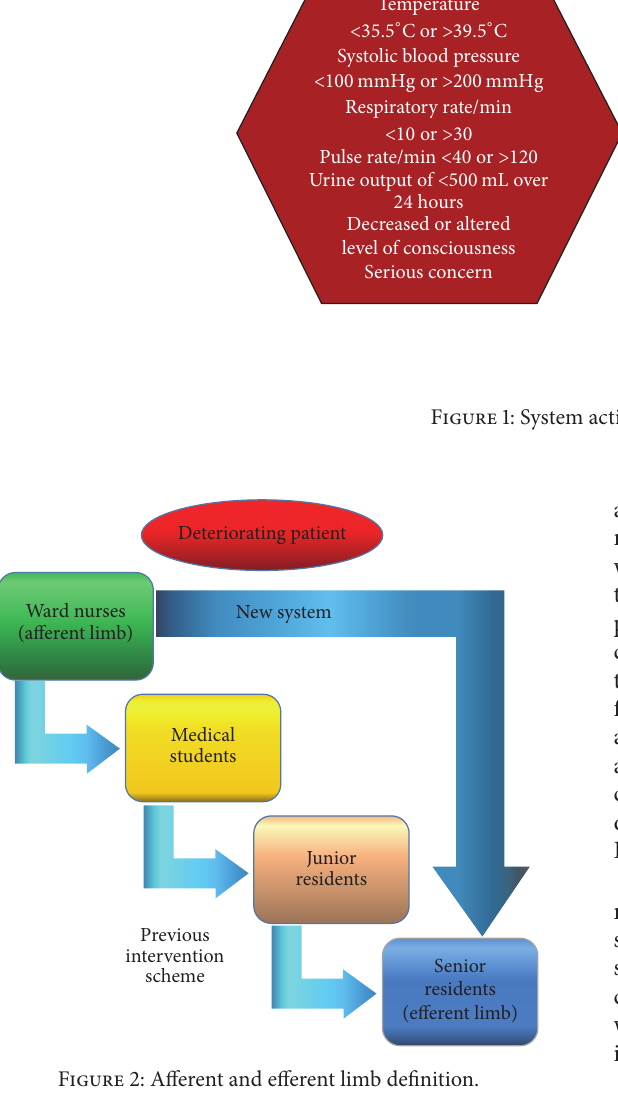
Figure 2: Afferent and efferent limb